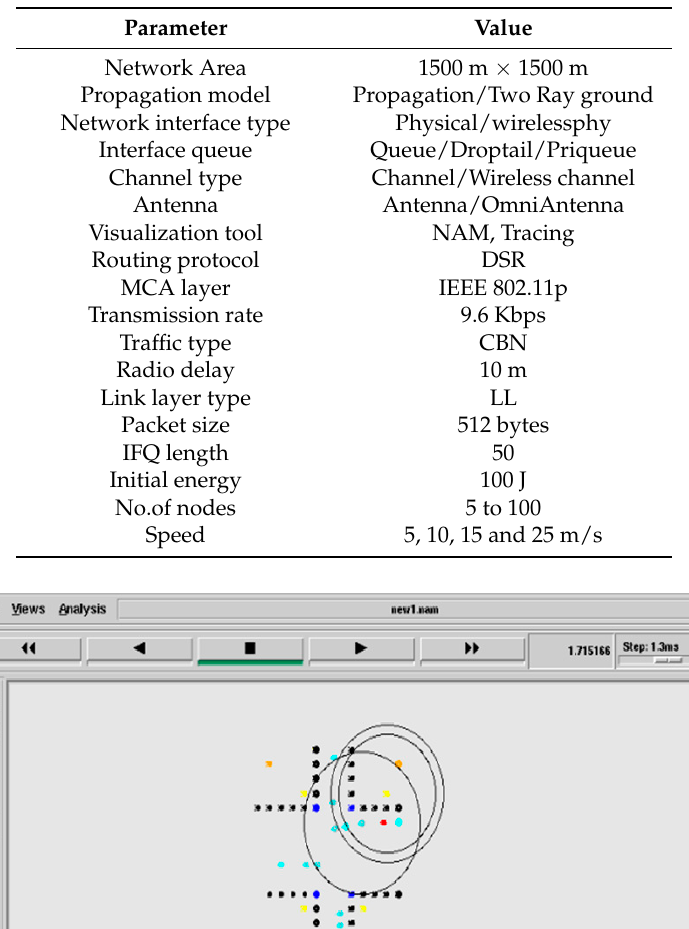
Table 3. Simulation parameters.